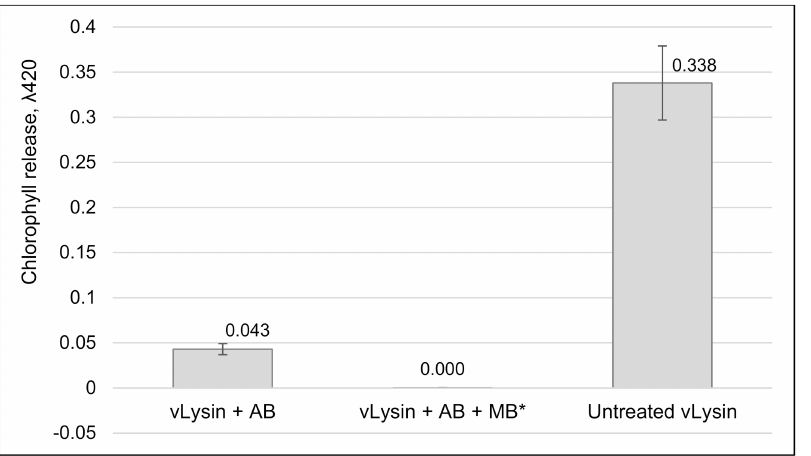
Figure 8. Effect of anti A561L D4 AB on vLysin activity. PBCV-1 isolated vLysin was treated with anti A561L D4 antibody (AB) produced in mice (800-fold dilution) for 1 h. After the incubation, anti-mouse Ig MB were added to the reaction and the supernatant fraction was separated from the magnetic beads following the manufacturer’s instructions. Antibody treated vLysin was mixed with NC64A cells and incubated for 1 h. The treated cells were subject to 1% SDS, spun down, the supernatant fraction was removed and chlorophyll release was measured at λ = 420. Untreated PBCV-1 vLysin was used as a positive control. NC64A cells treated with pre-bleed serum served as a negative control. Results are plotted as mean ± standard deviation ( n = 4), p -value 0.0001. (*) A mean of standard deviation for vLysin + AB + MB was